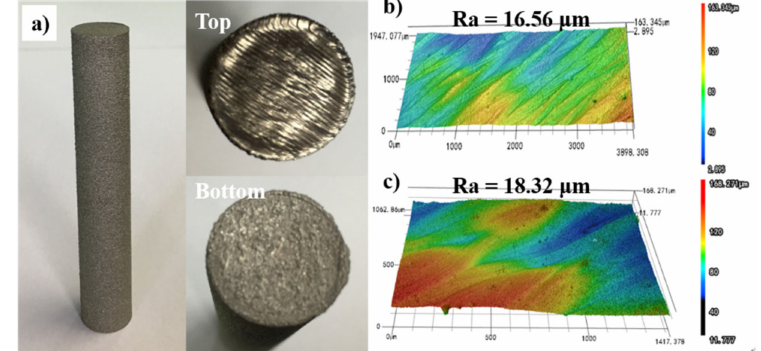
Figure 1. Cylindrical samples and surface morphology: ( a ) electron beam melting (EBM)-fabricated cylindrical samples; ( b ) surface morphologies of as-built sample; ( c ) surface morphologies of hot isostatic pressed (HIPed)